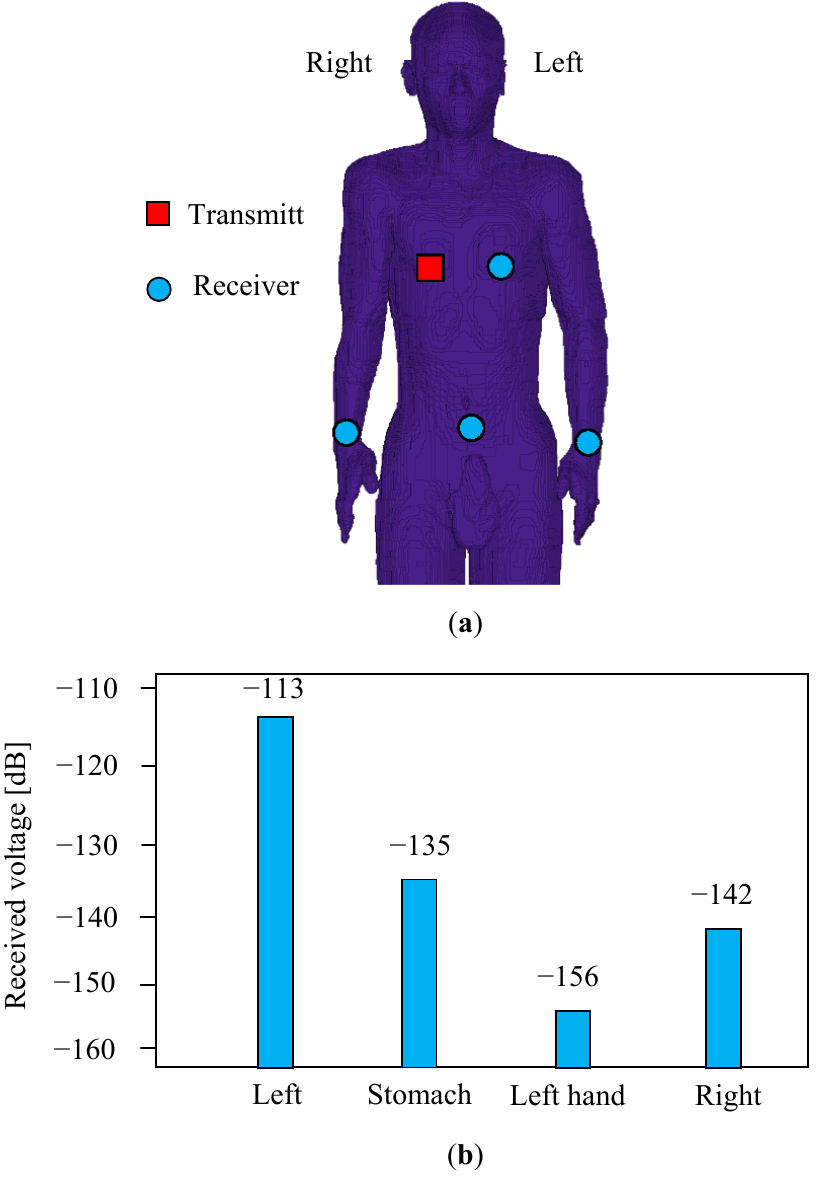
Figure 9. ( a ) Four different on-body links and ( b ) variation of received voltage for four different on-body